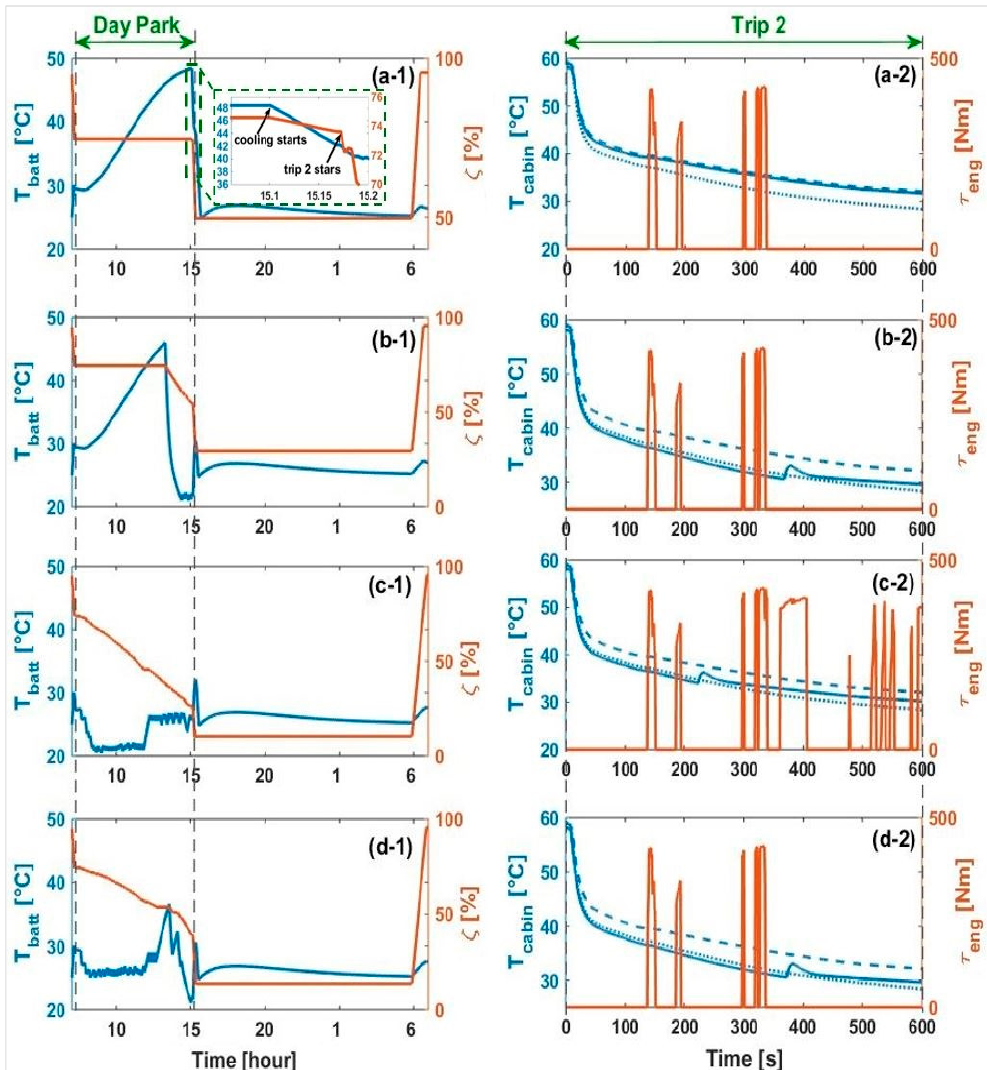
Figure 10. Result of optimizing key-off cooling of the battery for different weightings of objectives ( a-1 , a-2 ) λ = {1, 0, 0}; ( b-1 , b-2 ) λ = {0, 1, 0}; ( c-1 , c-2 ) λ = { 0, 0, 1 } ; and ( d-1 , d-2 ) λ = { 0.3, 0.3, 0.3 } . Annotations: left hand side figures (marked ‘1’) show the daily profile of the battery temperature (blue) and the SoC (red). In right-hand side figures (marked “2”), the cabin temperature in Trip 2 is plotted in blue, with solid line for optimized PHEV, with a dashed line for baseline PHEV, and with a dotted line for the conventional vehicle. Also the engine torque in Trip 2 is plotted in red.